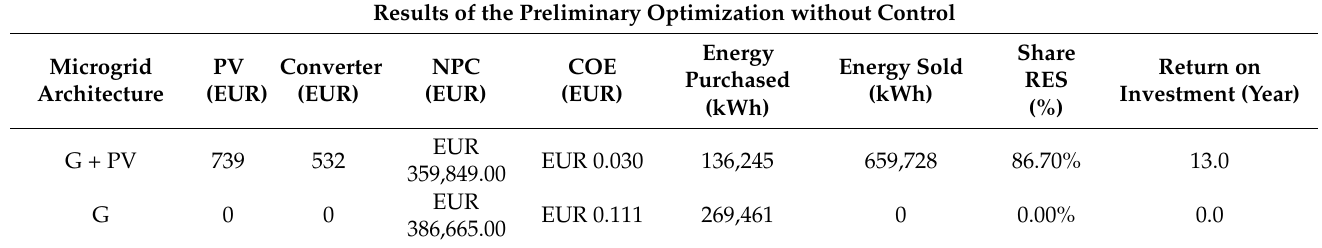
Table 4. Technical indicators of preliminary optimization without the